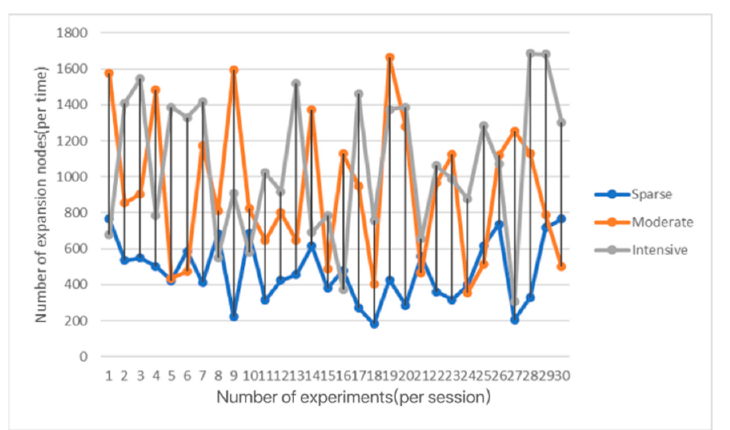
Figure 17. Comparison of number of extended nodes in each scenario for the AV-RRT algorithm.